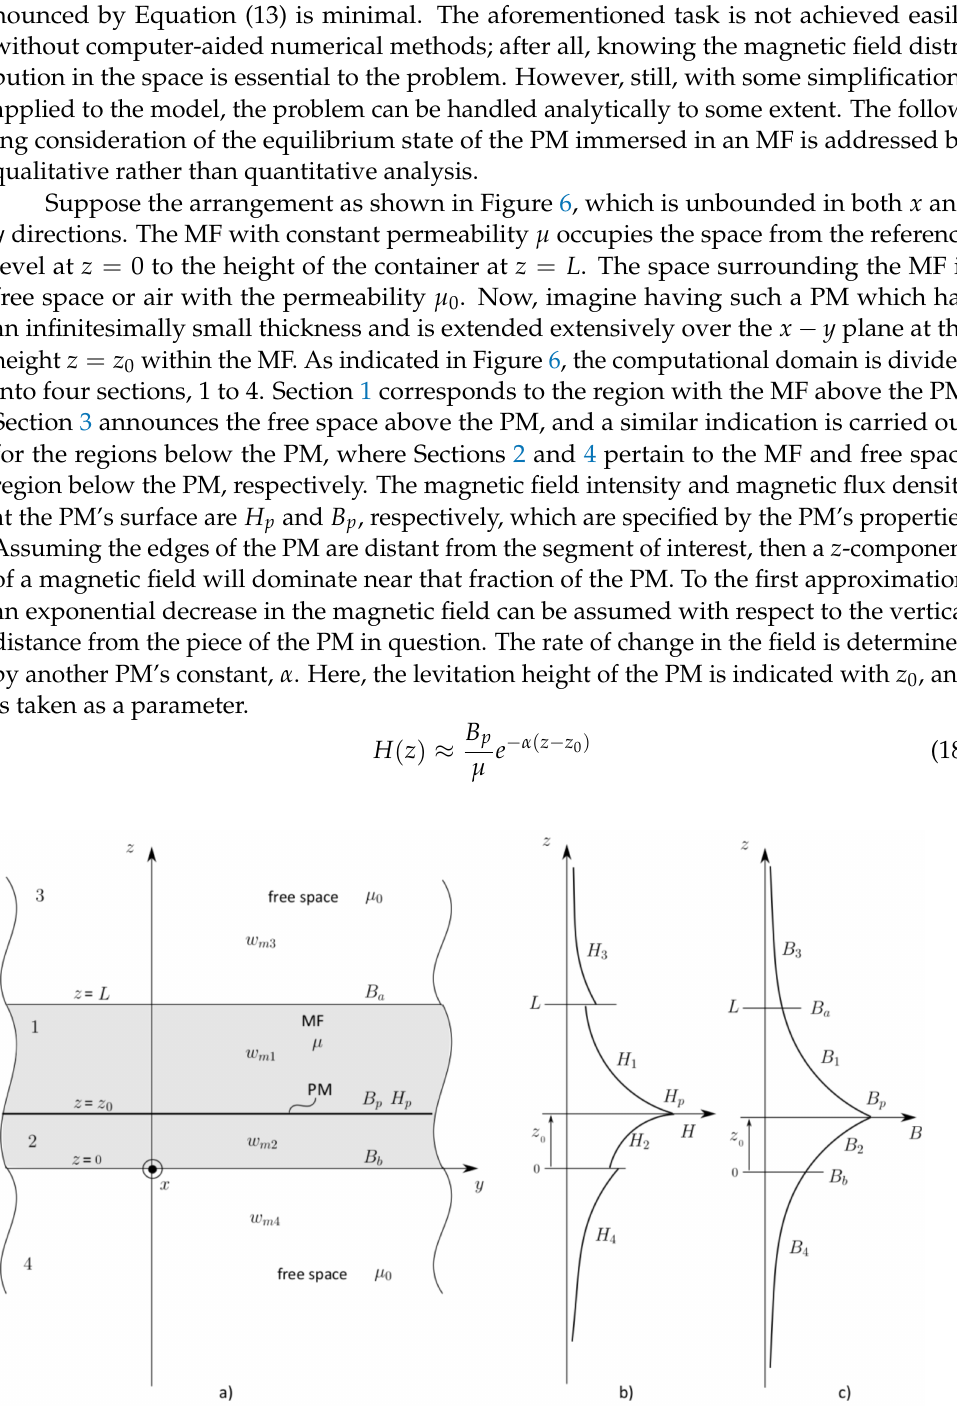
Figure 6. Simplified analytical model: ( a ) The MF is extended to infinity with respect to the x and y directions, and the PM is presented as an unbounded infinitesimal thin layer; ( b ) Magnetic field intensity decreases exponentially with the distance from the magnet, and has discontinuity when facing material with different permeability; ( c ) Magnetic flux density decreases exponentially and continuously with the distance from the